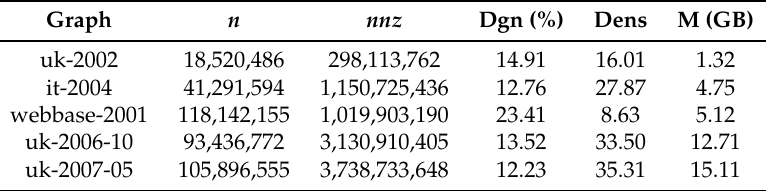
Table 2. Graphs collection. n = number of nodes, nnz =number of arcs, Dgn = percentage of dangling nodes, Dens = density (arcs/nodes), M = memory requirements using mCSR format. Graph n nnz Dgn (%) Dens M (GB) uk-2002 18,520,486 298,113,762 14.91 16.01